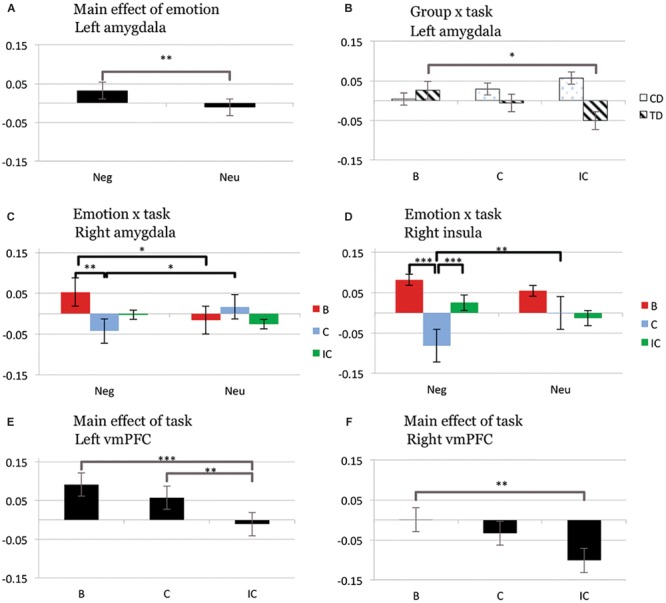
Bar graphs displaying mean values of parameter estimates (mean centered) in predefined regions of interest [amygdala, insula, ventromedial prefrontal cortex (vmPFC)] for the main effect of emotion and group × task interaction (left amygdala; A,B), emotion × task interaction (right amygdala and insula; C,D), and main effect of task (left and right vmPFC; E,F). B, blank trial; C, congruent trial; IC, incongruent trial; Neg, negative trial; Neu, neutral trial; CD, conduct disorder; TD, typically developing adolescents, ∗p < 0.05; ∗∗p < 0.01; ∗∗∗p < 0.001, two-tailed t-test; all other t-tests non-significant at threshold p = 0.05.